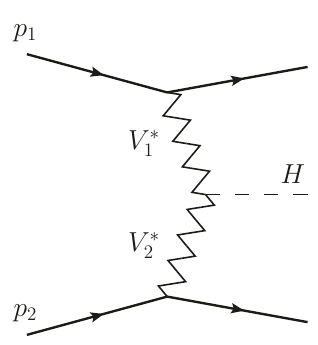
Figure 4. Born diagram T for single Higgs VBF